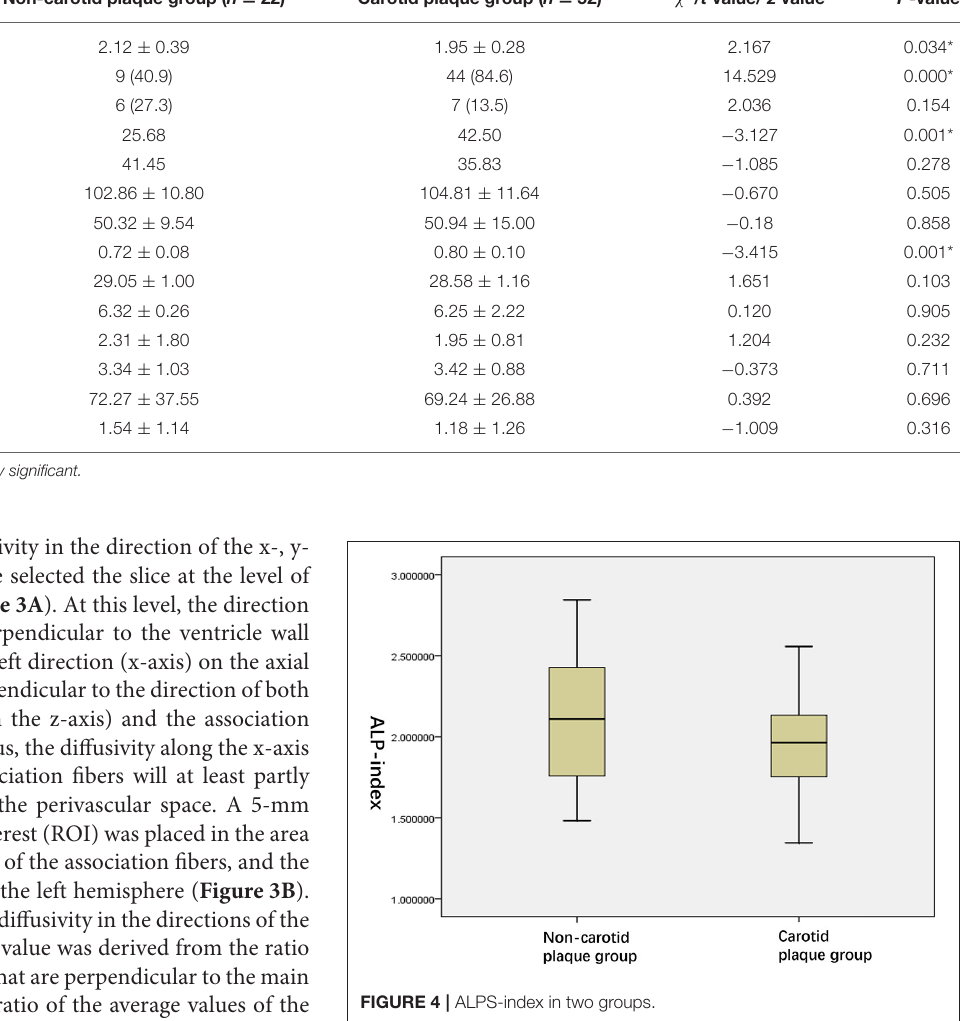
TABLE 2 | Imaging index and blood examination. Non-carotid plaque group ( n = 22) Carotid plaque group ( n = 52) χ 2 / t value/ z value